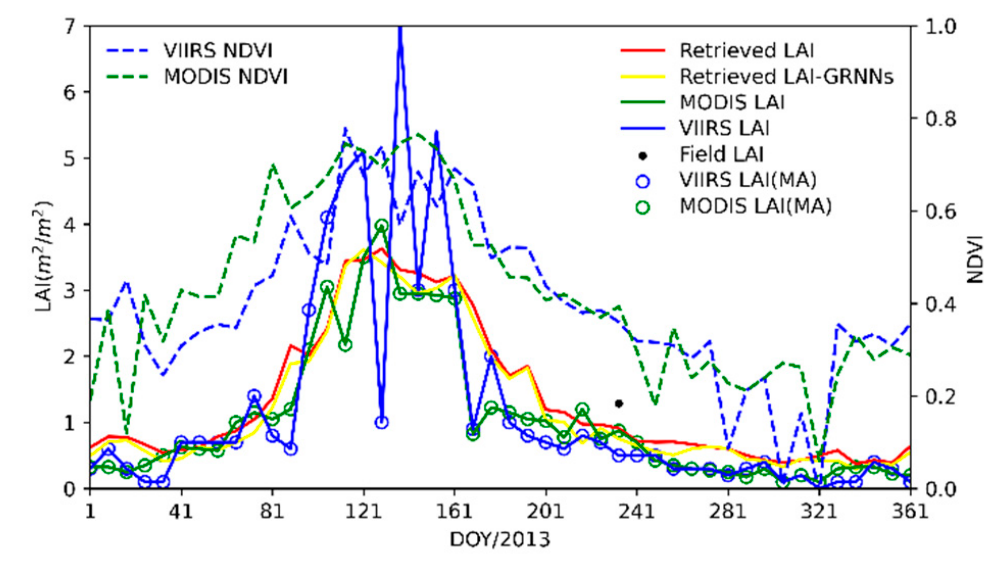
Figure 3. Temporal trajectories of the LAI-TCA and LAI-GRNN at the center pixel of the SouthWest_1 site for 2013.